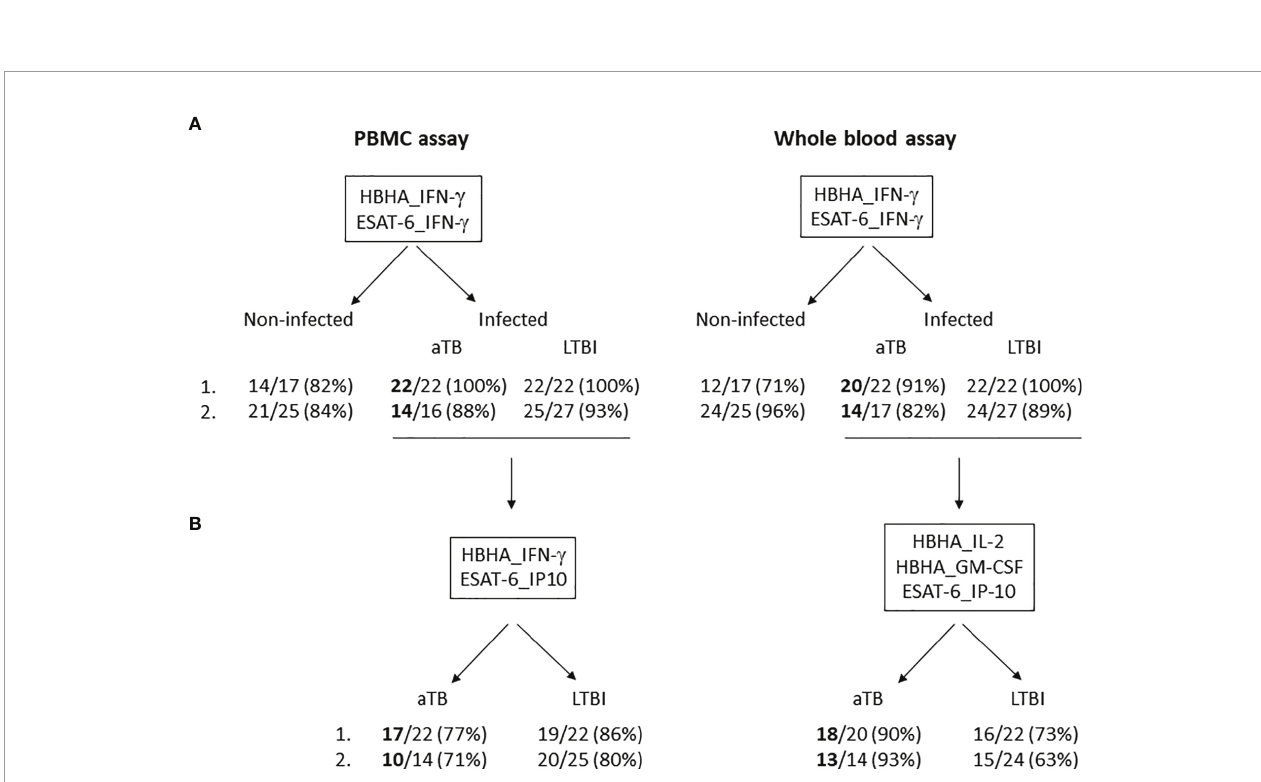
FIGURE 2 | Two-step algorithm for the identi fi cation of aTB and LTBI among M. tuberculosis -infected subjects by using a combination of cytokines/chemokines induced by two stage-speci fi c mycobacterial antigens in a PBMC- and WB-based assays. (A) M. tuberculosis -infected subjects, including aTB patients as well as LTBI subjects, were discriminated from non-infected subjects by using a combination of HBHA-IFN- g and ESAT-6-IFN- g in a PBMC- (left panel) and a WB- based assay (right panel) in a training (1.) and a validation cohort (2.). The numbers of well-classi fi ed subjects are indicated, as well as their percentages. (B) Patients with aTB were discriminated from LTBI subjects by using a combination of HBHA-IFN- g and ESAT-6-IP-10 in a PBMC-based assay (left panel) or of HBHA-IL2, HBHA-GM-CSF and ESAT-6-IP-10 in a WB-based assay (right panel) in a training (1.) and a validation cohort (2.). Only the M. tuberculosis -infected subjects well-classi fi ed in (A) were taken into account for this discrimination between aTB and LTBI. The numbers of well-classi fi ed subjects are indicated, as well as their